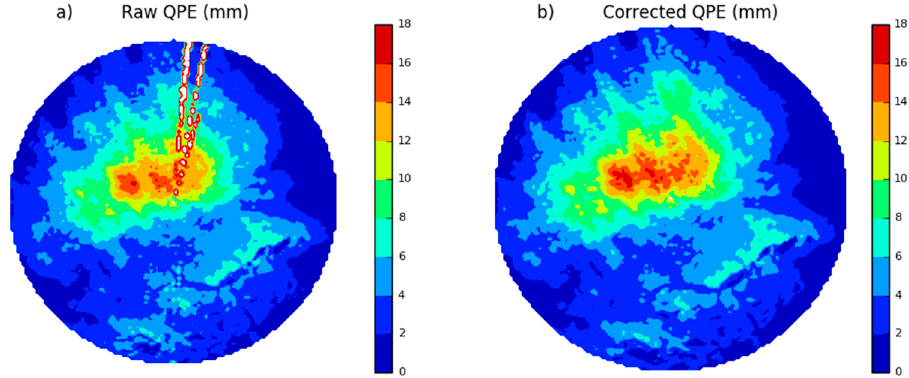
Figure 3. ( a ) Raw and ( b ) corrected radar quantitative precipitation estimation (QPE) from December 16, 2016 at 06:00 UTC to December 17, 2016 at 06:00 UTC.